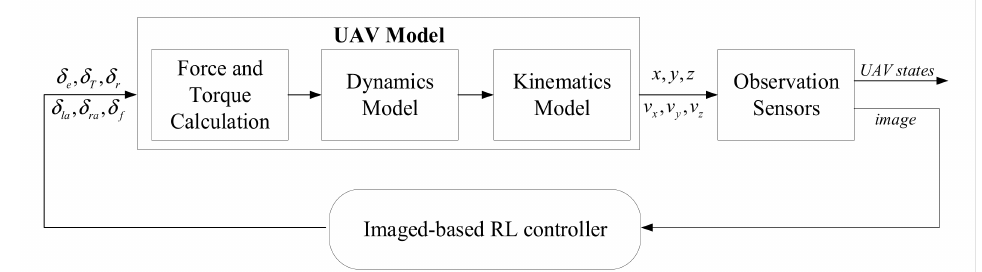
Figure 6. The relationship of the UAV model and the proposed controller.